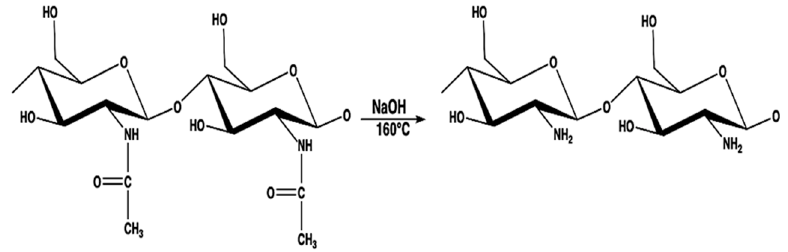
Figure 3. Deacetylation of chitin to obtain chitosan in alkaline medium.